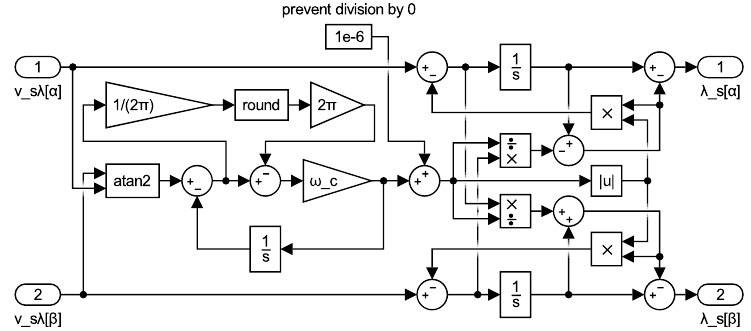
Figure 9. The Simulink diagram of the previous compensation presented in [23] and used for comparative simulations.